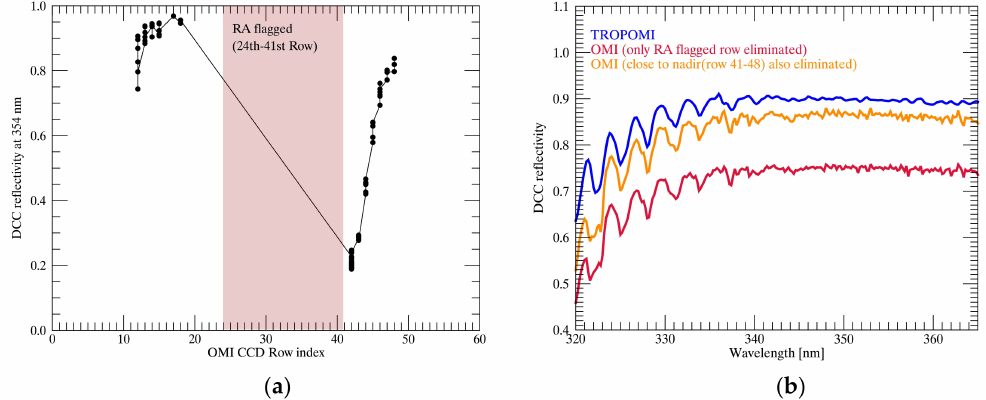
Figure 5. ( a ) DCC R 0.354 binned depending on the position of the detector in the OMI. The shaded red box indicates the RA flagged rows in the northern region of the orbit. ( b ) The DCC mean reflectivity spectrum of the OMI (the UV-2 product) containing the RA-a ff ected observations in comparison with TROPOMI